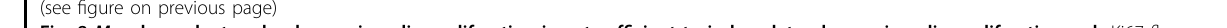
(Fig. 3b, c) suggested that A20 inhibits microglia pro- liferation, and that nerve injury suppressed the inhibitory effect of A20 to promote microglia proliferation. Impor-